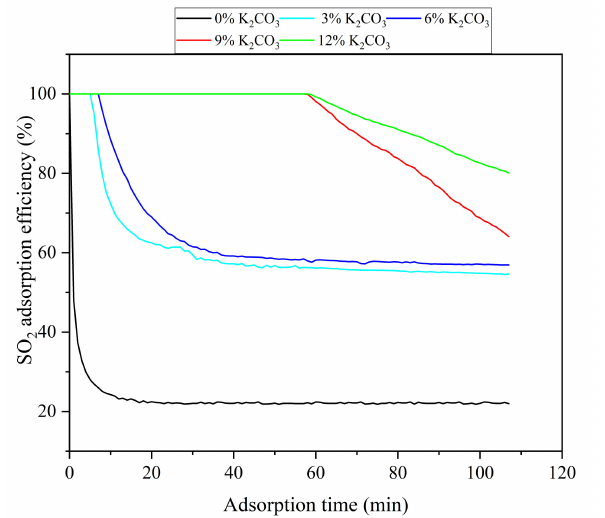
Figure 4. Effect of modified activated coke with different K 2 CO 3 concentrations on SO 2 adsorp- tion